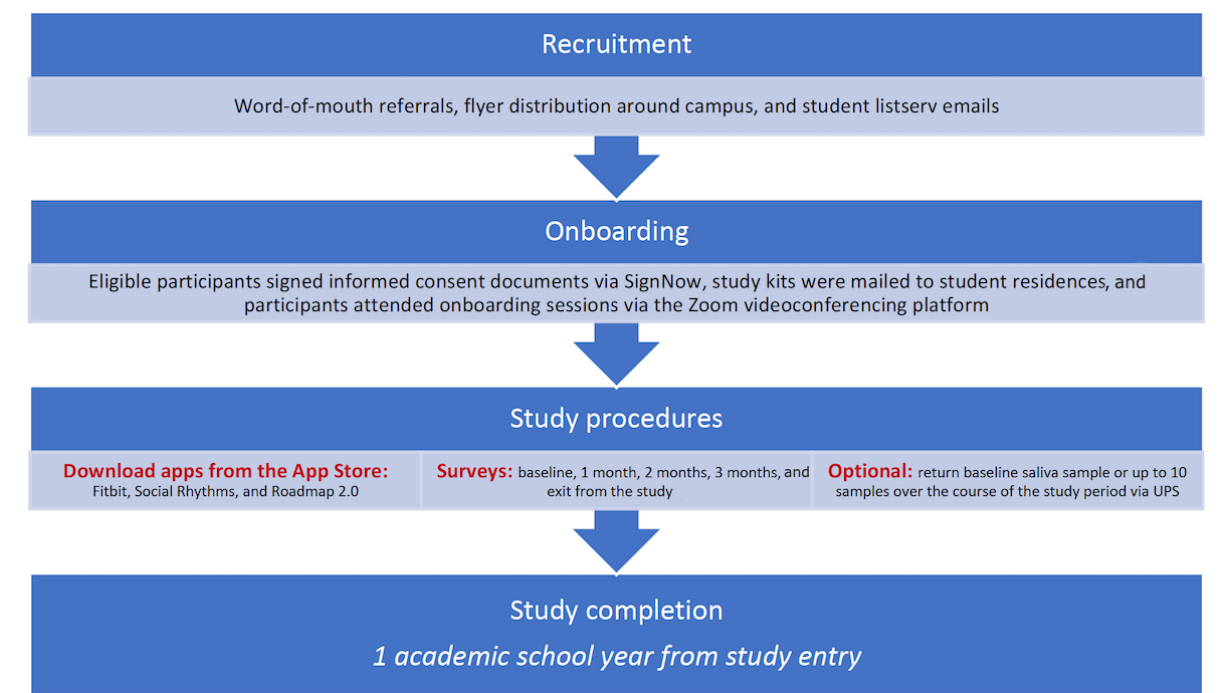
Figure 1. Schematic representation of the study protocol. UPS: United Parcel Service.